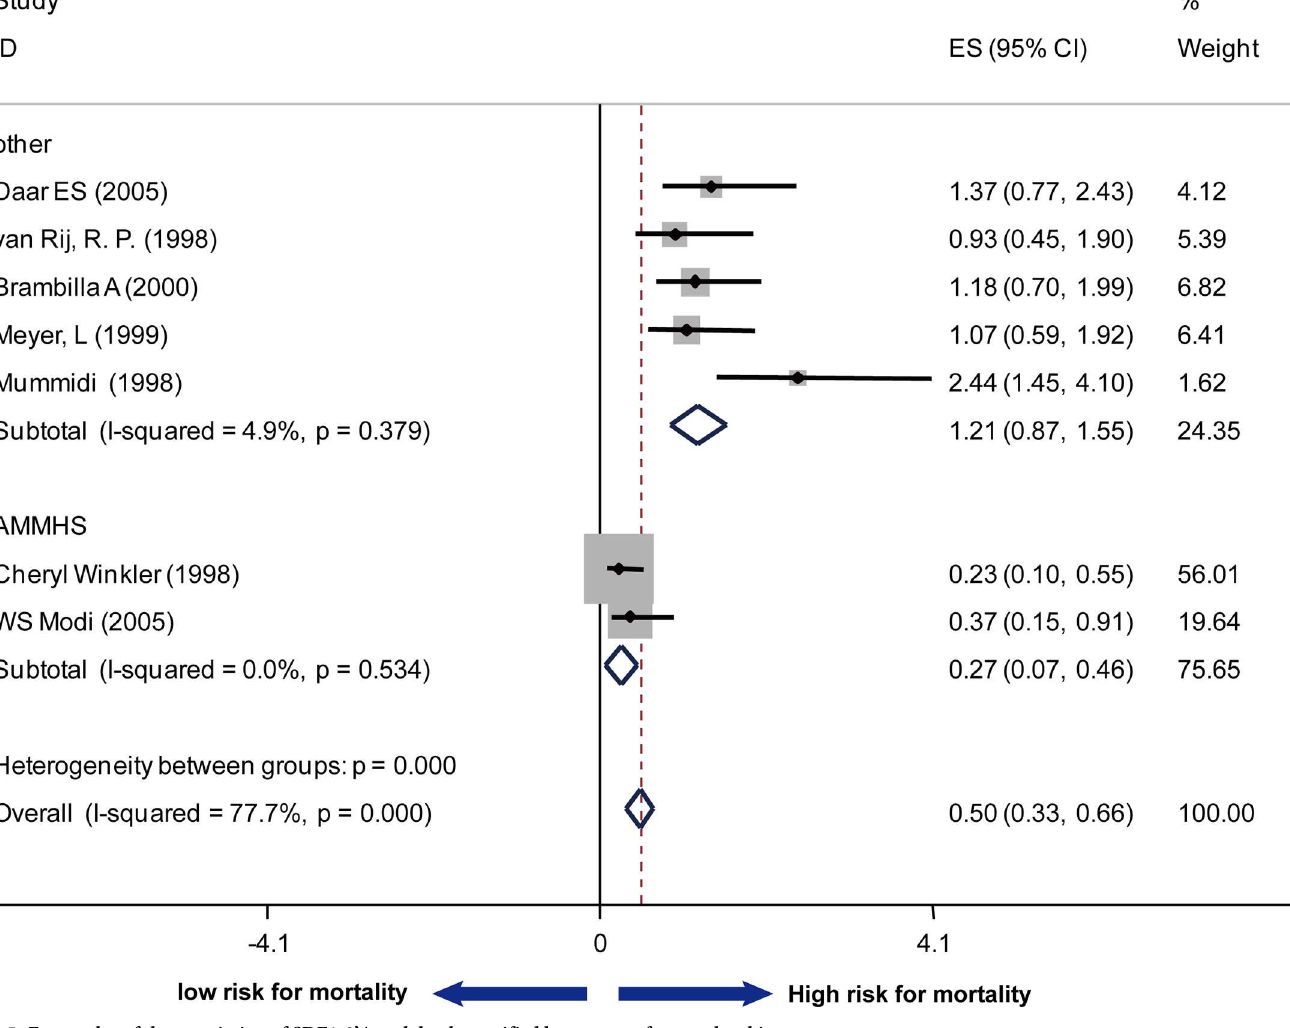
Fig 5. Forest plot of the association of SDF1-3’A and death stratified by sources of research subjects.